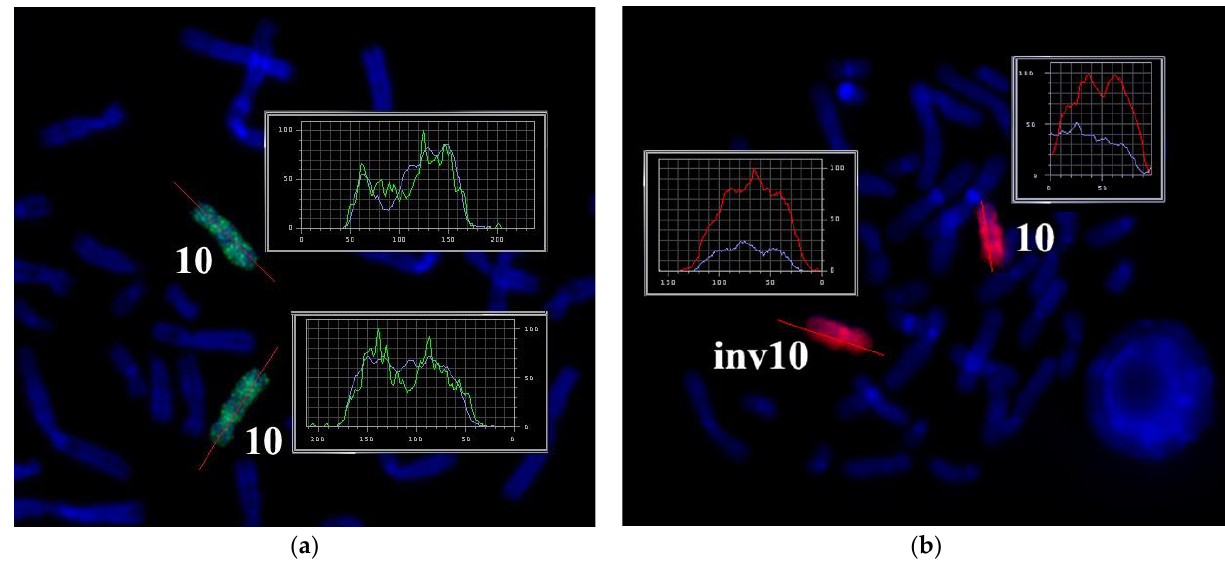
Figure 10. Suppression of FISH of the microdissected DNA probe of the abnormal chromosome (WCPinv10): ( a ) by metaphase chromosomes of a healthy individual (green signal) and ( b ) by metaphase chromosomes of the patient (red signal). Labels. 10: the normal homolog of chromosome 10; inv10: chromosome 10 containing the paracentric inversion in the long arm. Profiles of the intensity of the FISH signal and DAPI staining along chromosomes 10 and inv(10) are presented in the block. The intensity profiles of hybridization signals are determined relative to the line highlighted in red along chromosomes 10 and inv(10). Chromosomes were counterstained with DAPI (blue).